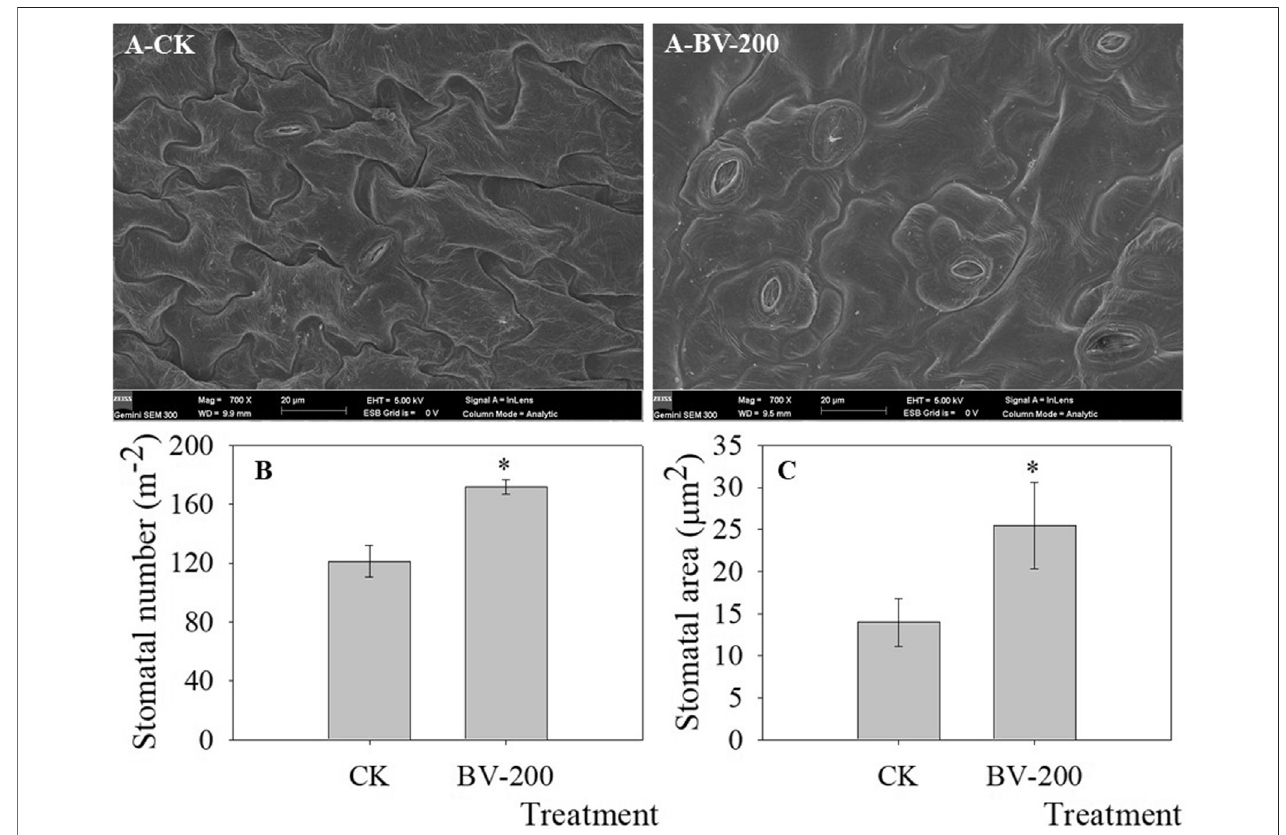
FIGURE5| StomataldensityandsizeintrueleavesrevealedbySEM.A-CKandA-BV-200werethecontroland200 μ gml -1 BV,respectively.BarsinFigureAwere 20 µm (mag (cid:2) 700 × ). (A) Stomatal number per square (stomatal density). (B) Mean area per stomata (stomatal size, µm 2 ). Asterisks above the bar indicate that there were signi fi cant differences between the two treatments at p < 0.05.